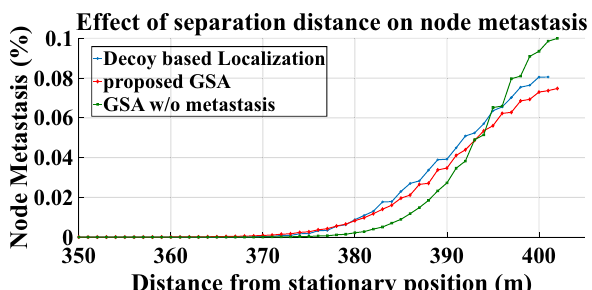
Figure 4. Effect of separation distance on node metastasis.